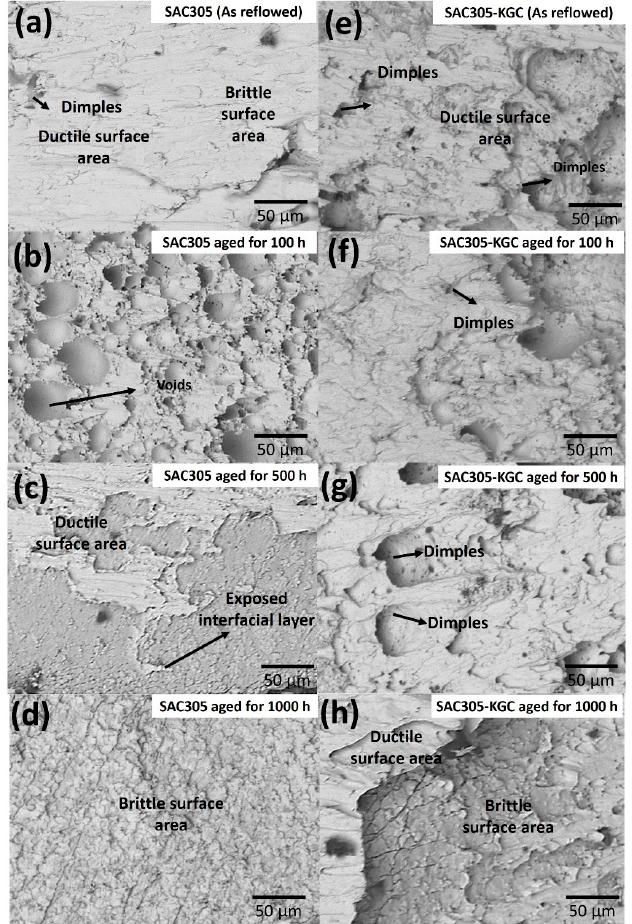
Figure 17. SEM micrographs of fracture surfaces subjected to isothermal ageing at 150 °C for non- reinforced SAC305 ( a ) as-reflowed, ( b ) 100 h, ( c ) 500 h, ( d ) 1000 h and SAC305-KGC composite solder ( e ) as-reflowed, ( f ) 100 h, ( g ) 500 h and ( h ) 1000 h.